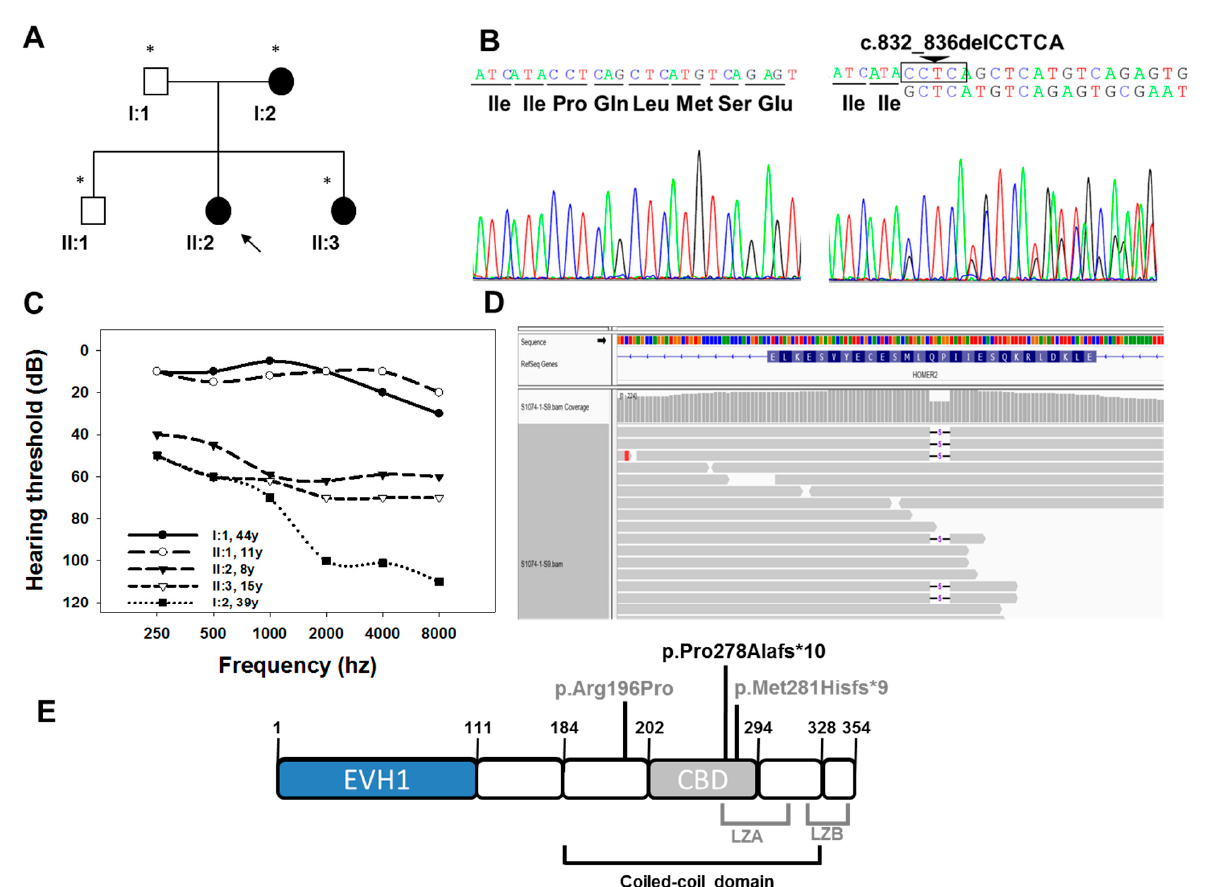
Figure 1. ( A ) Pedigree of the S1074 family indicating the segregation of c.832_836delCCTCA mutation in HOMER2 . Black symbols indicate affected patients (carrying the mutation in heterozygosis), and white symbols correspond to normal hearing individuals (wild-type for the mutation studied). The subject pointed with an arrow is the index case (studied by OTO-NGS-v2 panel), and the ones marked with an asterisk were analysed by Sanger sequencing for segregation analysis. ( B ) Electropherograms corresponding to the wild-type (left) and mutant (right) sequences of a normal hearing and an affected individual, respectively. ( C ) Audiograms of the S1074 family. The data represented correspond to the average of the audiometric thresholds in both ears. ( D ) Integrative Genomics Viewer (IGV) (Broad Institute) screenshot showing the genomic region corresponding to the c.832_836delCCTCA mutation of HOMER2 and the translated protein stretch corresponding to exon 8 in the reverse orientation (NP_955362.1, HOMER2 long isoform, amino acid range 292–266), as HOMER2 is transcribed by using the DNA negative strand. ( E ) Schematic representation of the structure of HOMER2 long isoform (NP_955362.1). The different domains [7,14,21] and the mutations identified so far associated with hearing loss (in grey) are shown. The mutation identified in this work is shown in black. EVH1 (1–111 aa): Enabled/vasodilator-stimulated phosphoprotein (Ena/VASP) homology 1; Coiled-coil domain (184–328 aa); CBD (202–294 aa): CDC42-binding